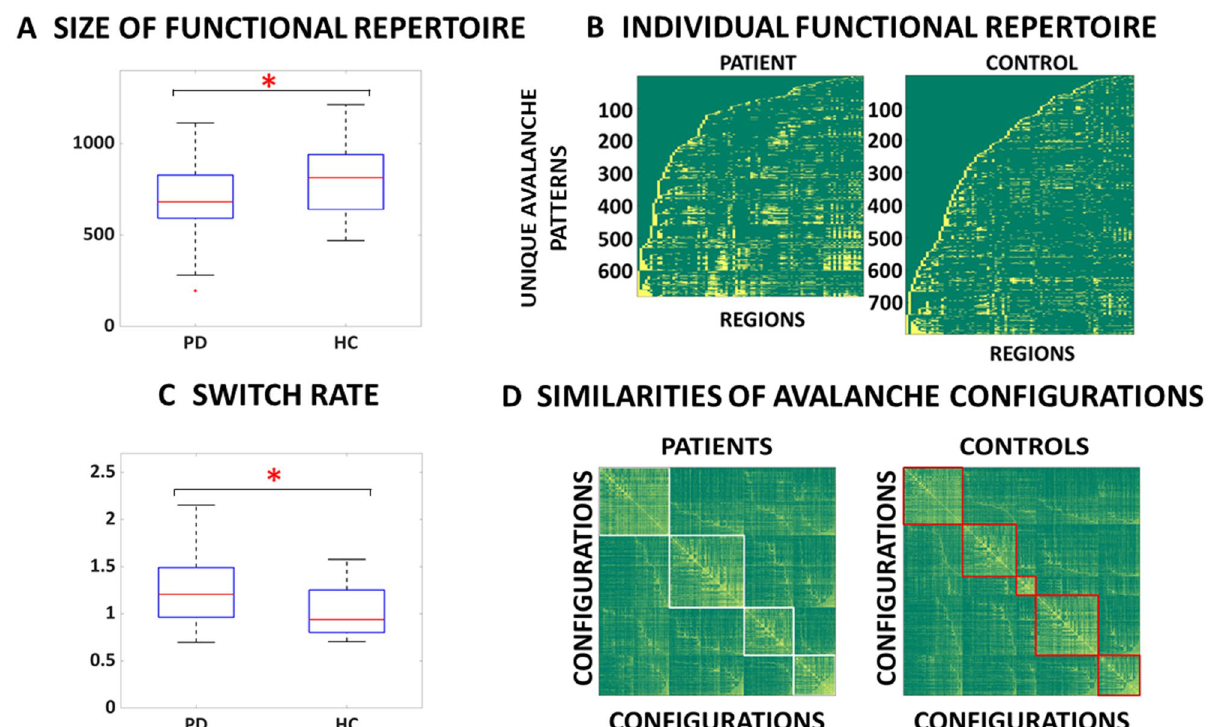
Figure 2. Functional repertoire computed from high spatiotemporal MEG data. ( A ) The number of unique avalanche configurations in PD and healthy controls (HC). The central mark in the box indicates the median, and the edges of the box the 25th and 75th percentiles. The whiskers extend to 3 standard deviations, and the outliers are plotted individually using the ’+’ symbol. ( B ) Avalanche configurations for two representative participants (regions above threshold in yellow, regions below threshold in green). On the x-axis, the 90 AAL regions (cortex and basal ganglia). Along the y axes, one can see each of the unique patterns that constitute the functional repertoire of the individual. ( C ) The number of switches for the two groups. ( D ) Boolean similarities between avalanche configurations. Rows and colums show all avalanche configurations that are present in each cohort. The entries are the boolean similarities (i.e. yellow indicates higher similarity). The matrix-entries have been re-ordered using the Louvain modularity algorithm (as implemented in the brain connectivity toolbox), to graphically highlight the presence of clusters. The coloured lines (white and red) show the clusters in patients and controls, respectively. The figure was done using MatlabR2019a and Inkscape 1.0.